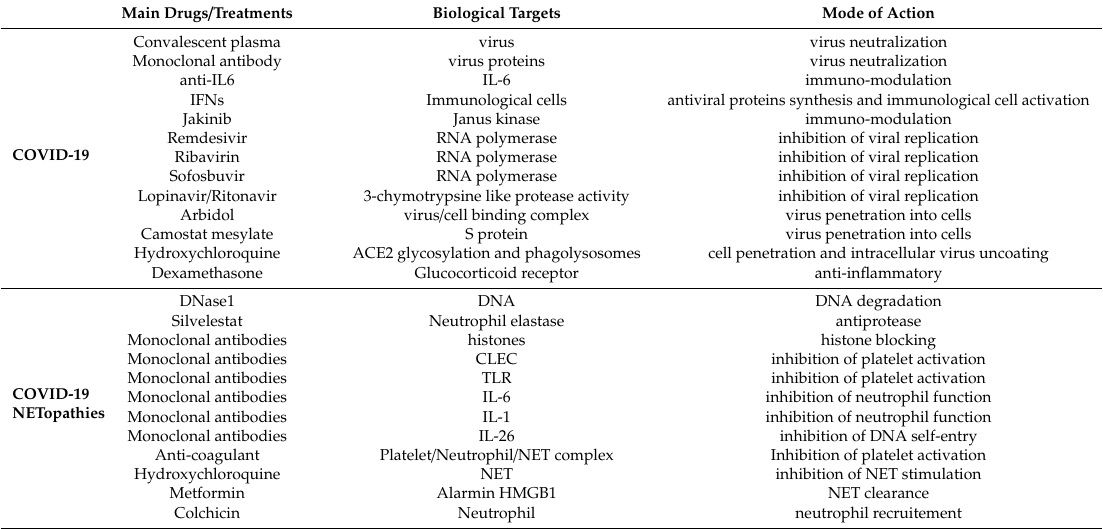
Table 3. Comparison of COVID-19 studied treatments and proposed NETopathies